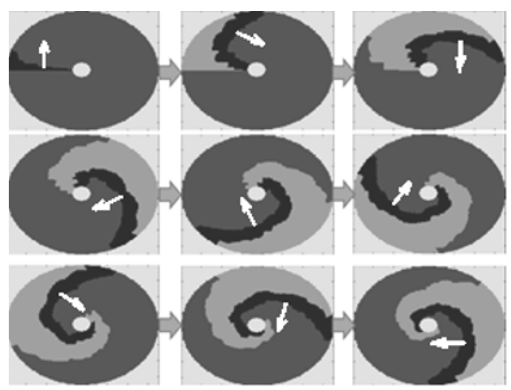
Fig. 4. Concave autowave in axiomatic model. The color coloring in the output is as follows: black-a point in the state of excitation, light gray-a point in the state of relative refractoriness, dark gray-a point at rest. The total delay from the head to the tail-about 3/4 of the treatment